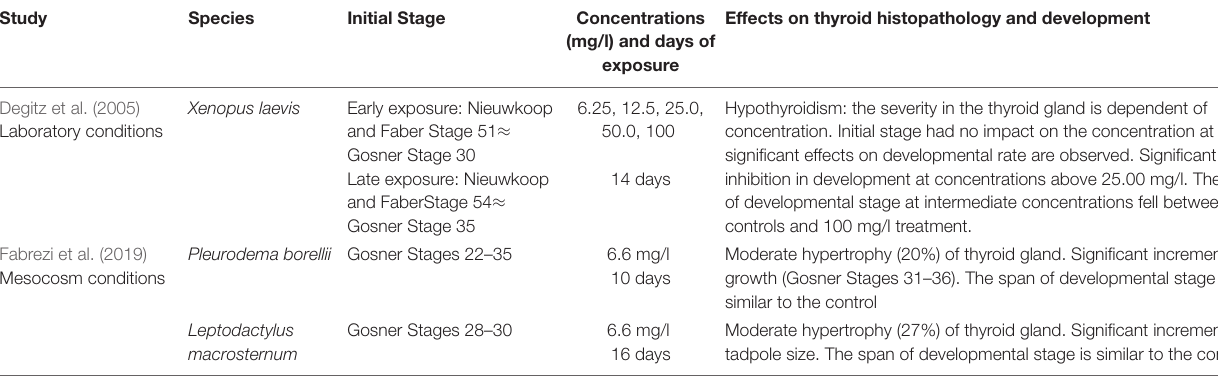
TABLE 1 | Comparison of studies of larval development of anuran species exposed to methimazole.